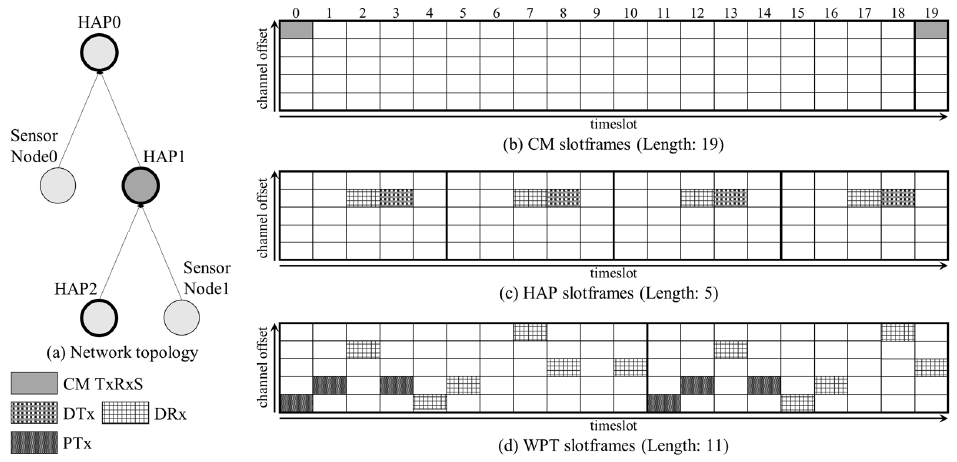
Figure 3. Example of multiple concurrent slotframes in MCSS.